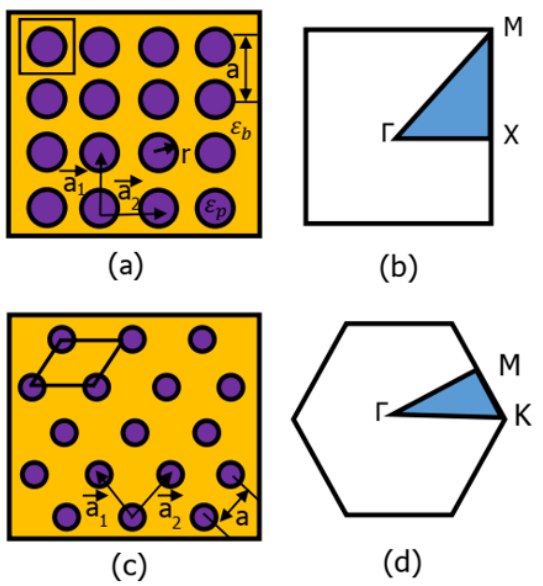
Figure 3. Schematics of a square lattice ( a ) and a triangular lattice ( c ) and the corresponding reduced Brillouin zone boundaries ( b – d ). Here a is the lattice constant; r is the radius of the plasma column; a 1 , a 2 denote the base vectors of the lattices; ε a and ε p indicate the dielectric constants of the gas and plasmas, respectively. The areas enclosed by the black and rhombus at the top left of ( a , c ) indicate the basic unit of the plasma photonic crystals. In figures ( b , d ), the triangular regions surrounded by M- Γ -X-M and M- Γ -K-M are the irreducible Brillouin regions which are utilized for calculating of the dispersion relations.